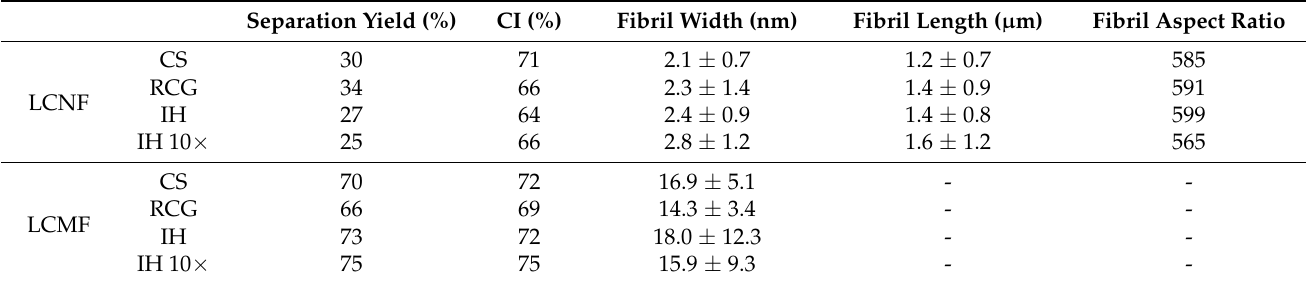
Table 1. Separation yields of LCNF and LCMF fractions after centrifugation and their structural and morphological characteristics (crystallinity index, fibril width and length, and fibril aspect